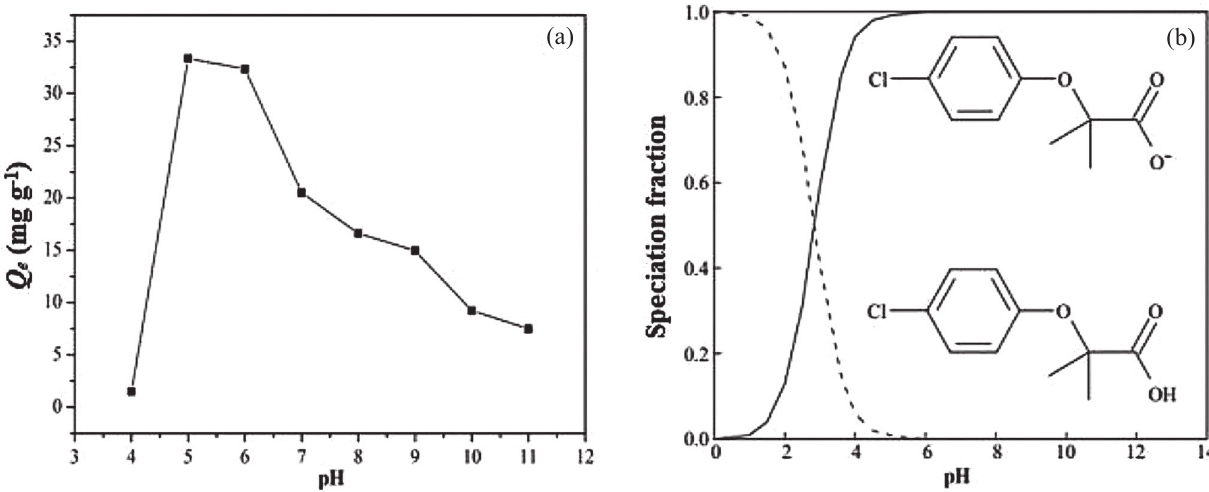
Fig. 2 – Quantities of CA retained by 30 mg CLDH as a function of pH (a), and speciation diagram of CA 45